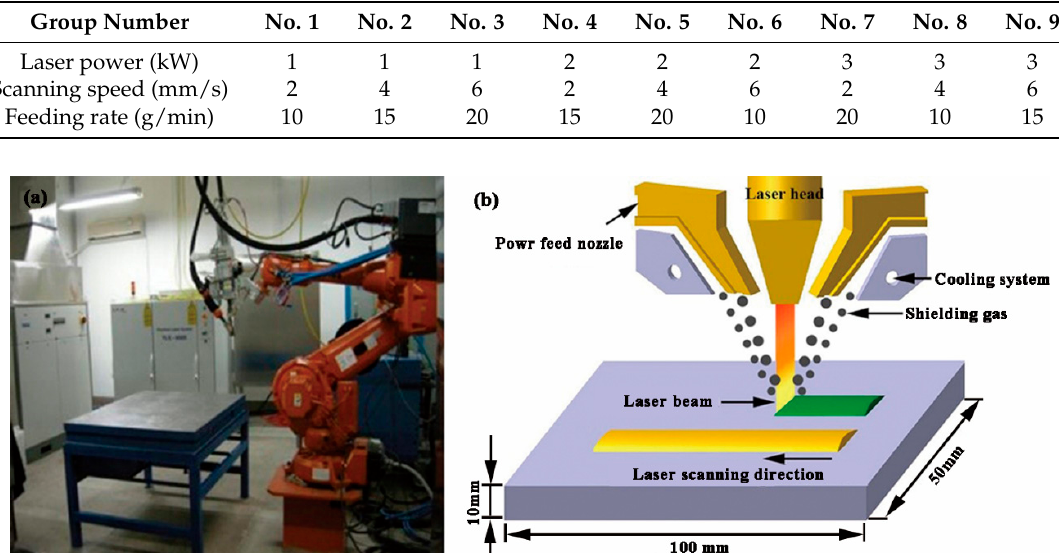
Table 2. The different parameters of orthogonal experiment groups.